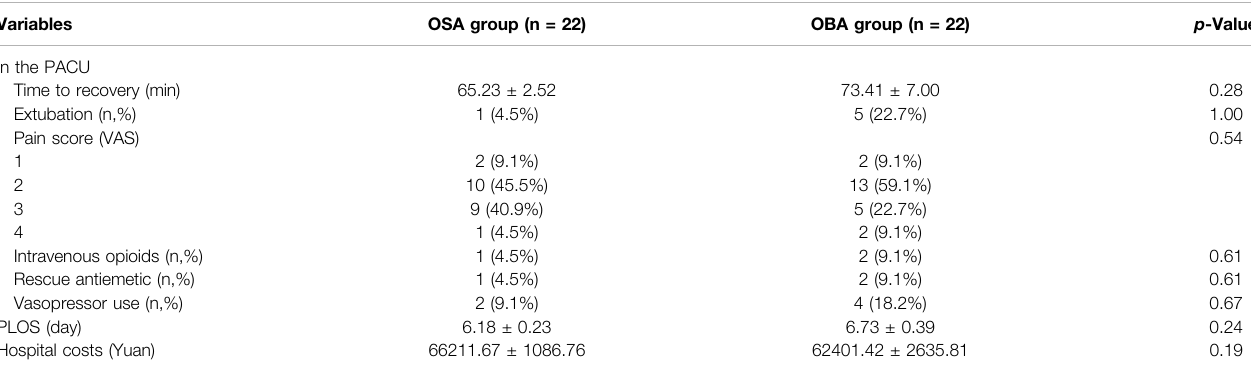
TABLE 3 | Postoperative data of